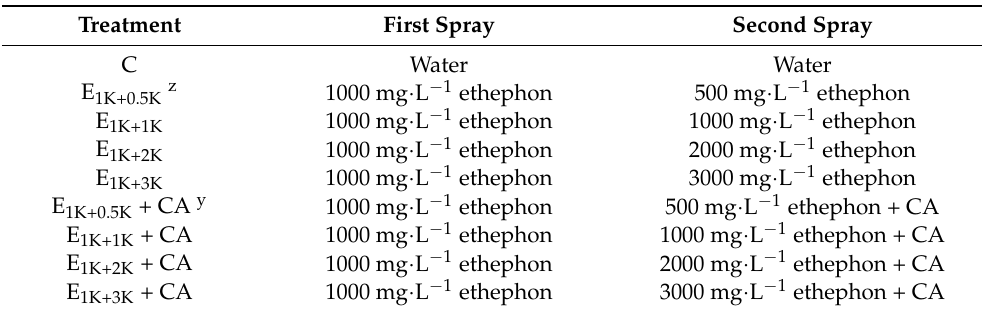
Table 1. Nine treatments combining water and different doses of ethephon with and without calcium acetate (CA) solutions in two sprays in summer 2020. Two species, camphor and golden shower trees, were tested and compared. The first foliar spray was on 11 May, and the second spray was on 14 May. Each treatment had six